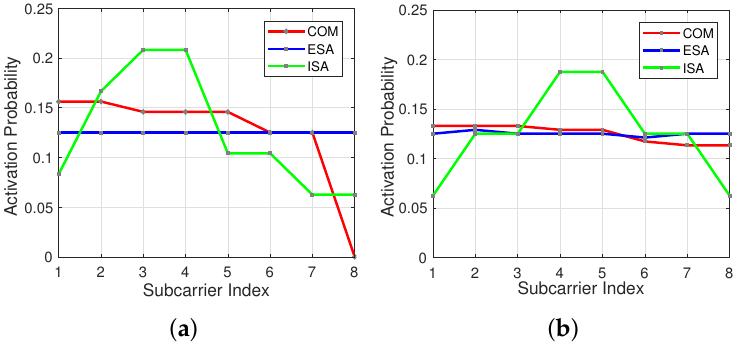
Figure 6. Subcarrier usage probability within an OFDM-IM subblock for the three SMS-s regarding to different ( s , v ) . ( a ) s = 8 and v = 3. ( b ) s = 8 and v =